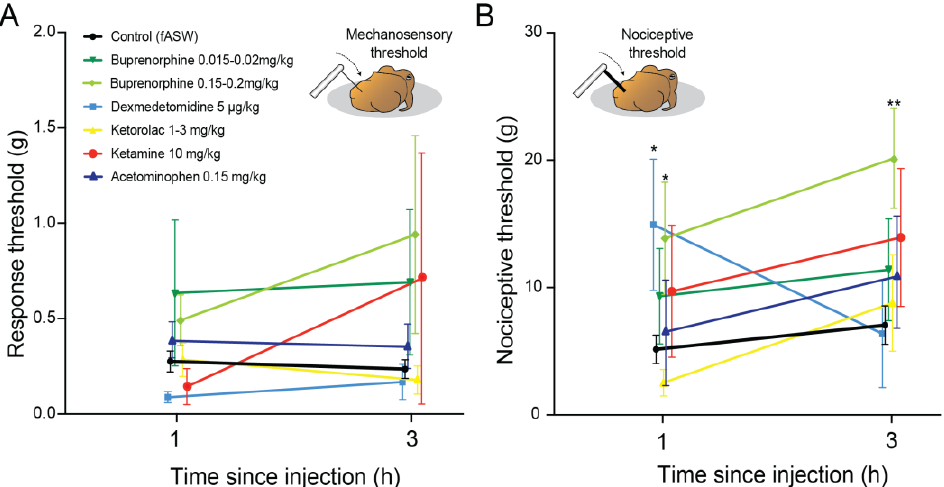
Figure 2. Responses of uninjured, healthy squid to applications of an ascending series of von Frey filaments after receiving candidate analgesics. ( A ) Response thresholds (color change, movement of individual body parts, or slow avoidance movements) were tested at one and three hours after drug dosing. Responses were typically variable and no significant effects were found compared with control squid injected with sterile seawater (unpaired t – tests, all NS). Refer to Table 2 for sample sizes. ( B ) Nociceptive thresholds were determined by recording instances of either inking, reflexive, high-speed escape jetting, or stimulus-directed arm grooming. At one hour nociceptive thresholds were elevated in squid given dexmedetomidine ( p = 0.0071) and high-dose buprenorphine ( p = 0.0098), compared with control squid (unpaired, Bonferroni-corrected t – tests). At three hours only squid given high dose buprenorphine showed continued elevation of nociceptive thresholds ( p = 0.0071). Points show mean and error bars show standard error of the mean (SEM). *, p<0.05. **p<0.01)